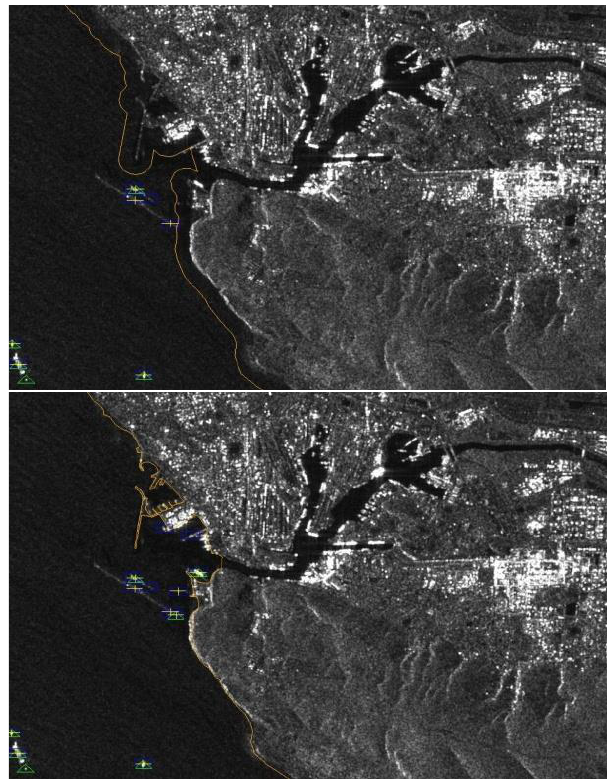
Fig.4 Detection results of SUMO ship detector on the Vishakhapatnam port with different land masks to detect ships in the sea and at the port. Land mask applied are sea buffered by 0m (below) and by 250m (above).